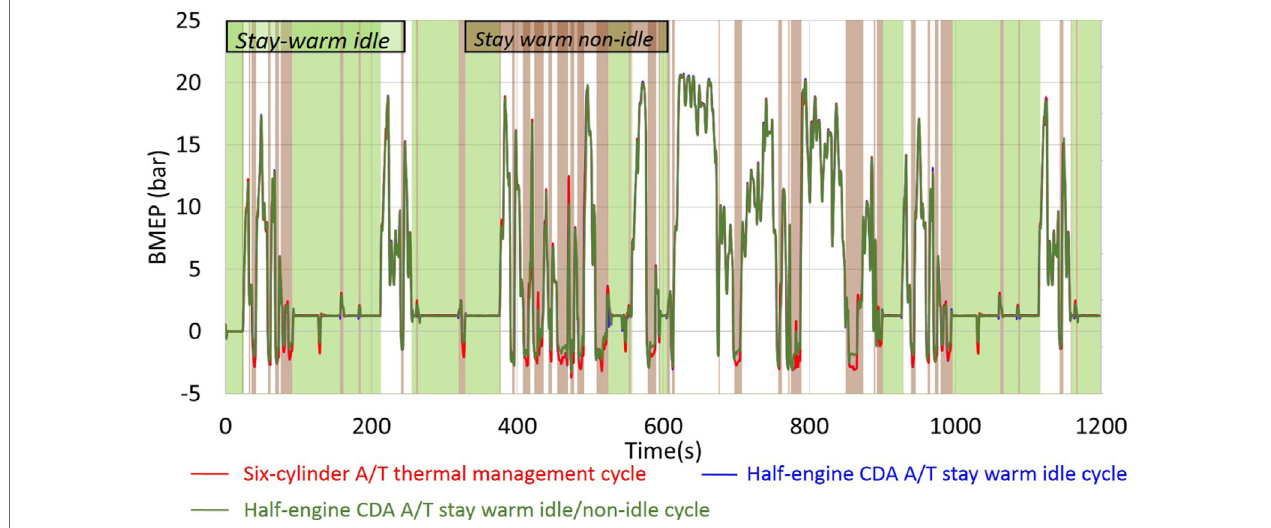
FigUre 19 | The torque responses during the “Six-cylinder A/T thermal management cycle” and the “Half-engine CDA A/T stay-warm idle cycle” are essentially the same, demonstrating the torque response is not compromised as the engine transitions into, and out, of Half-engine CDA operation at idle and non-idle.